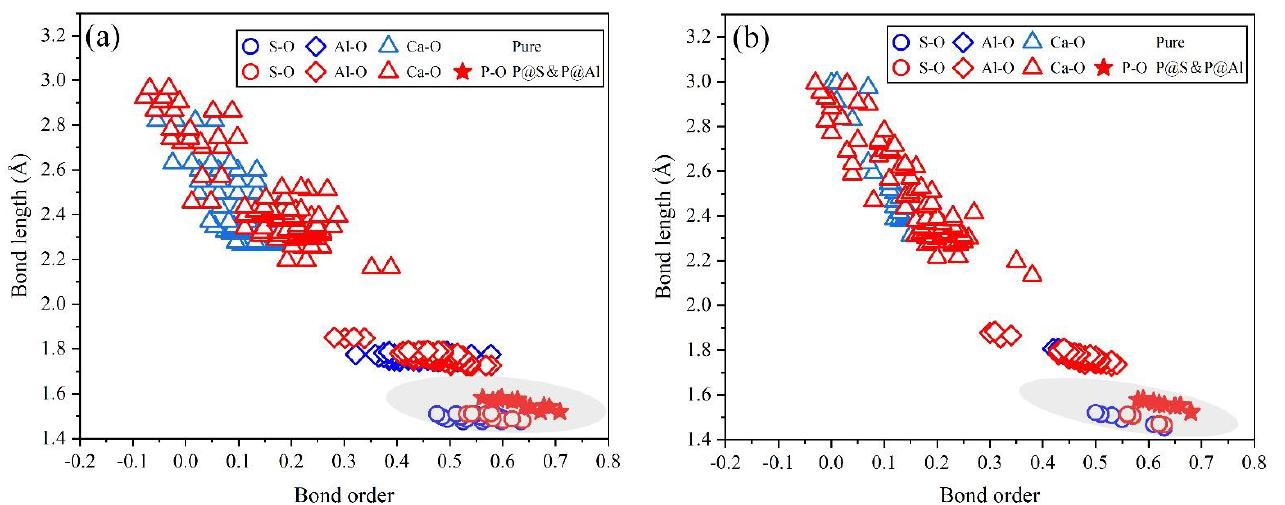
Table A4. Total energy ( E t ), Bonding energy ( E b ) and defect formation energy ( E f ) of substituted elements X (X = Ca, Al, and S). and S). Sample